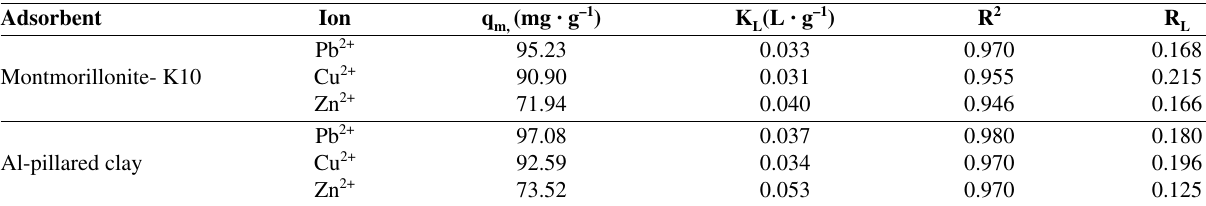
Table 4. Parameters and correlation coefficients calculated for Langmuir adsorption model for Pb 2+ , Cu 2+ and Zn 2+ on montmorillonite-K10 and Al- pillared clay. Adsorbent